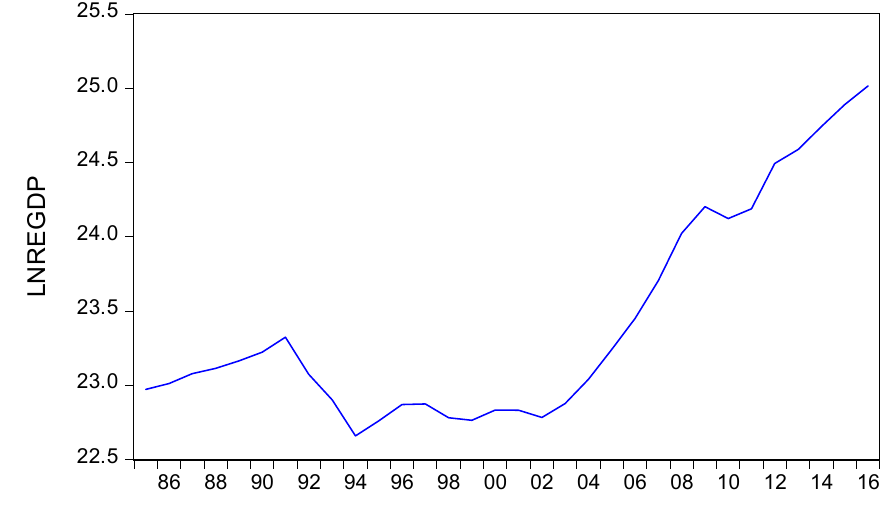
Figure 4. Trends in LnRGDP in Ethiopia, 1985–2016.